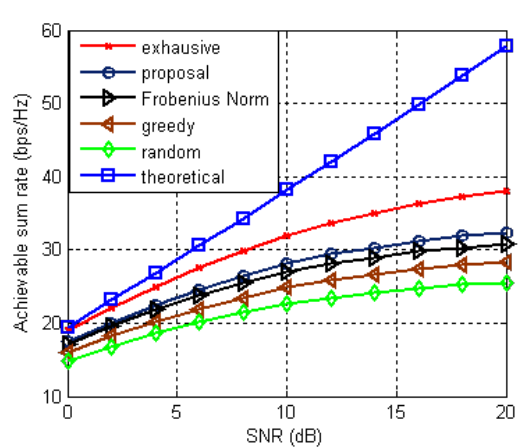
Table 2. The complexity order of different user selection scheme